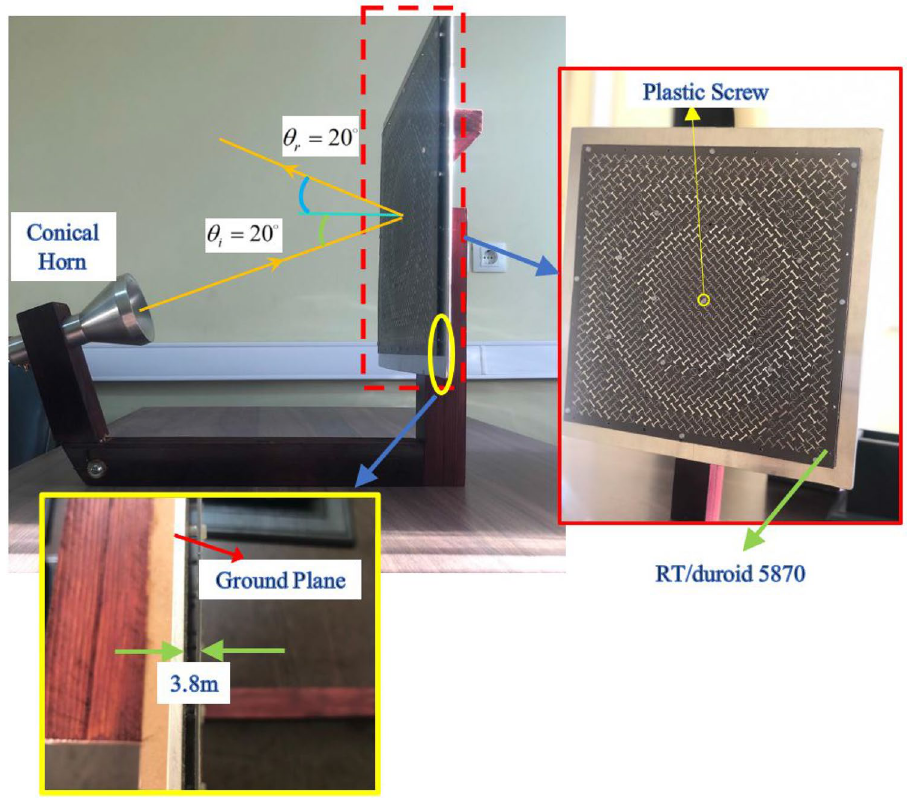
Figure 13. Fabrication of a prototype of metasurface and its position with respect to the horn antenna as the feeding